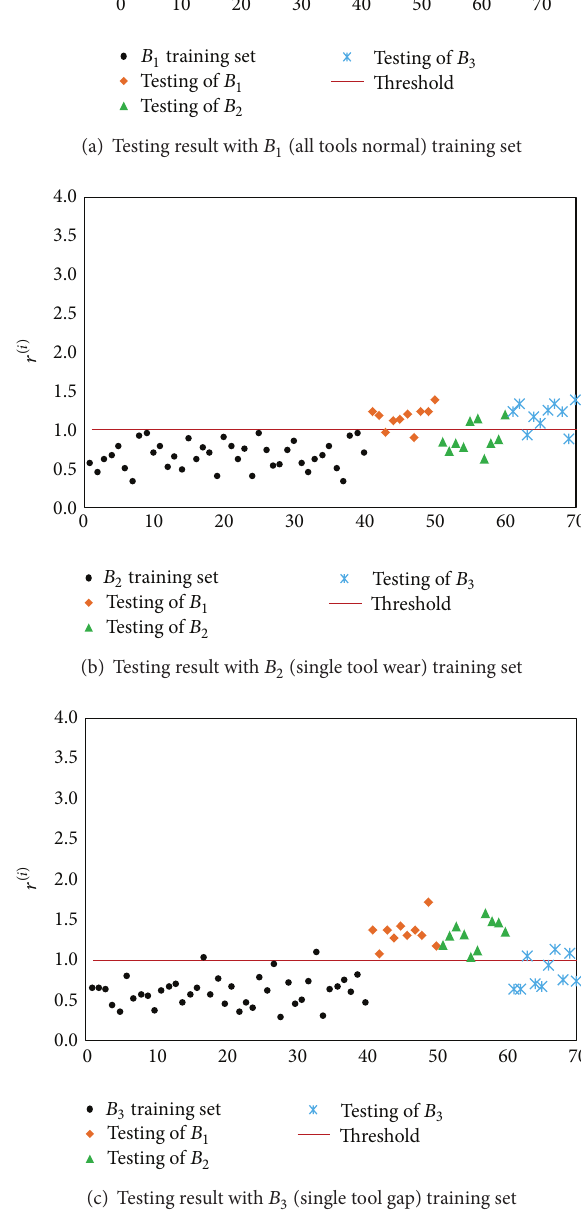
Figure 6: Test results of three classes with proposed method. Figure 7: Test results of three classes with PCA-MFD- 𝑘 NN